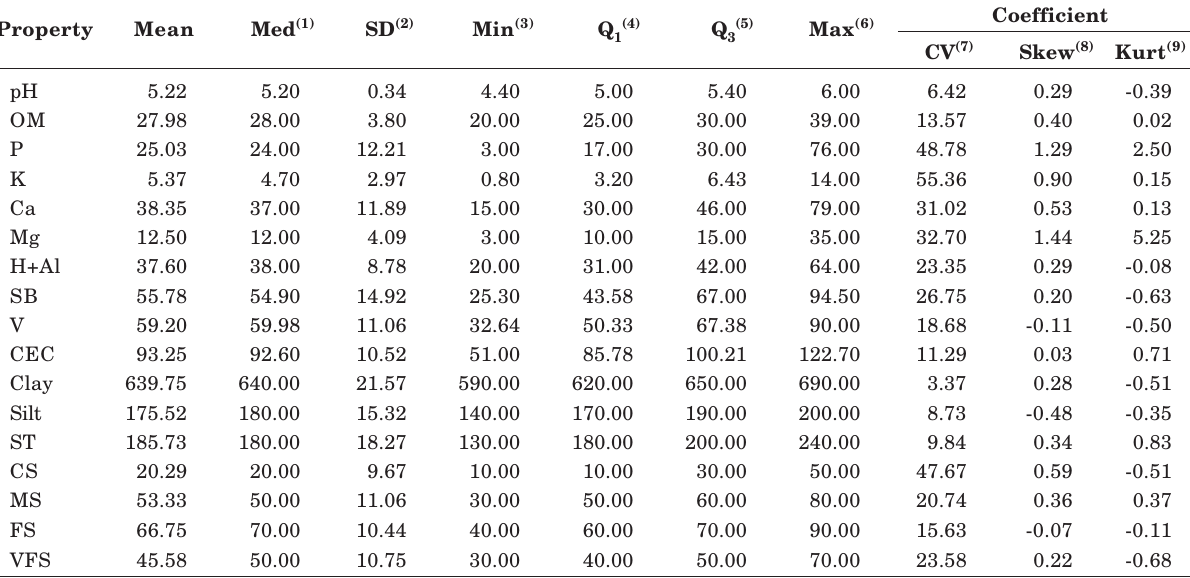
Table 1. Descriptive statistics of physical and chemical properties in the 0.0-0.20 m layer